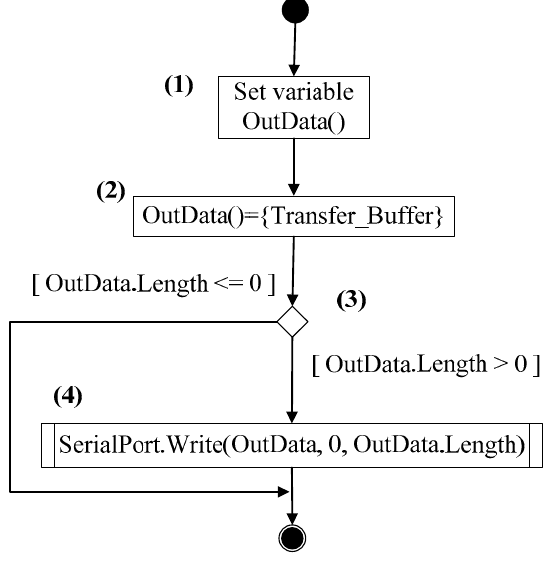
Figure 8. The ‘send’ function of UART communication.